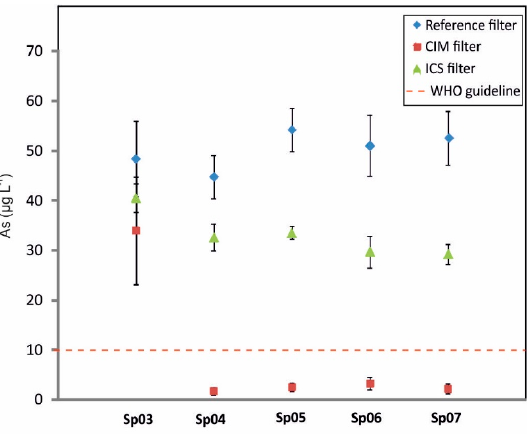
Figure 4. Arsenic concentration at different sampling ports (03 to 07) along the filter column.